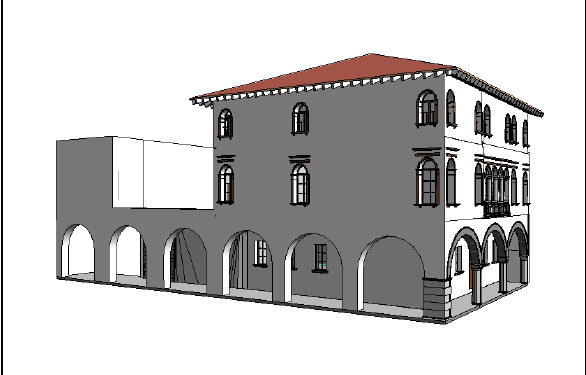
Figure 5. HBIM model obtained by Revit.